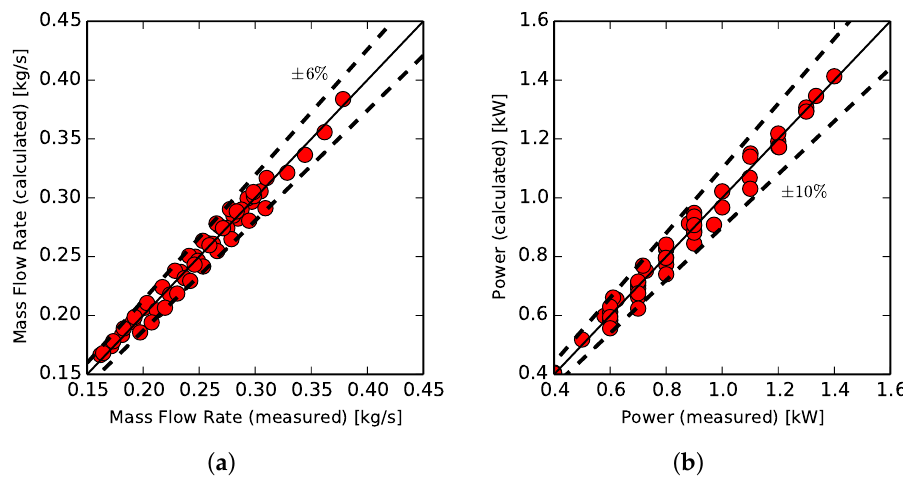
Figure 9. Validation of the centrifugal pump (Calpeda MXV-25-214) model installed in the regenerative ORC with R245fa at UGent Campus Kortrijk . Dashed lines show the maximum relative errors of all the 57 steady-state points. ( a ) Mass flow rate MAPE = 2.63%; ( b ) Input power MAPE = 3.08%.